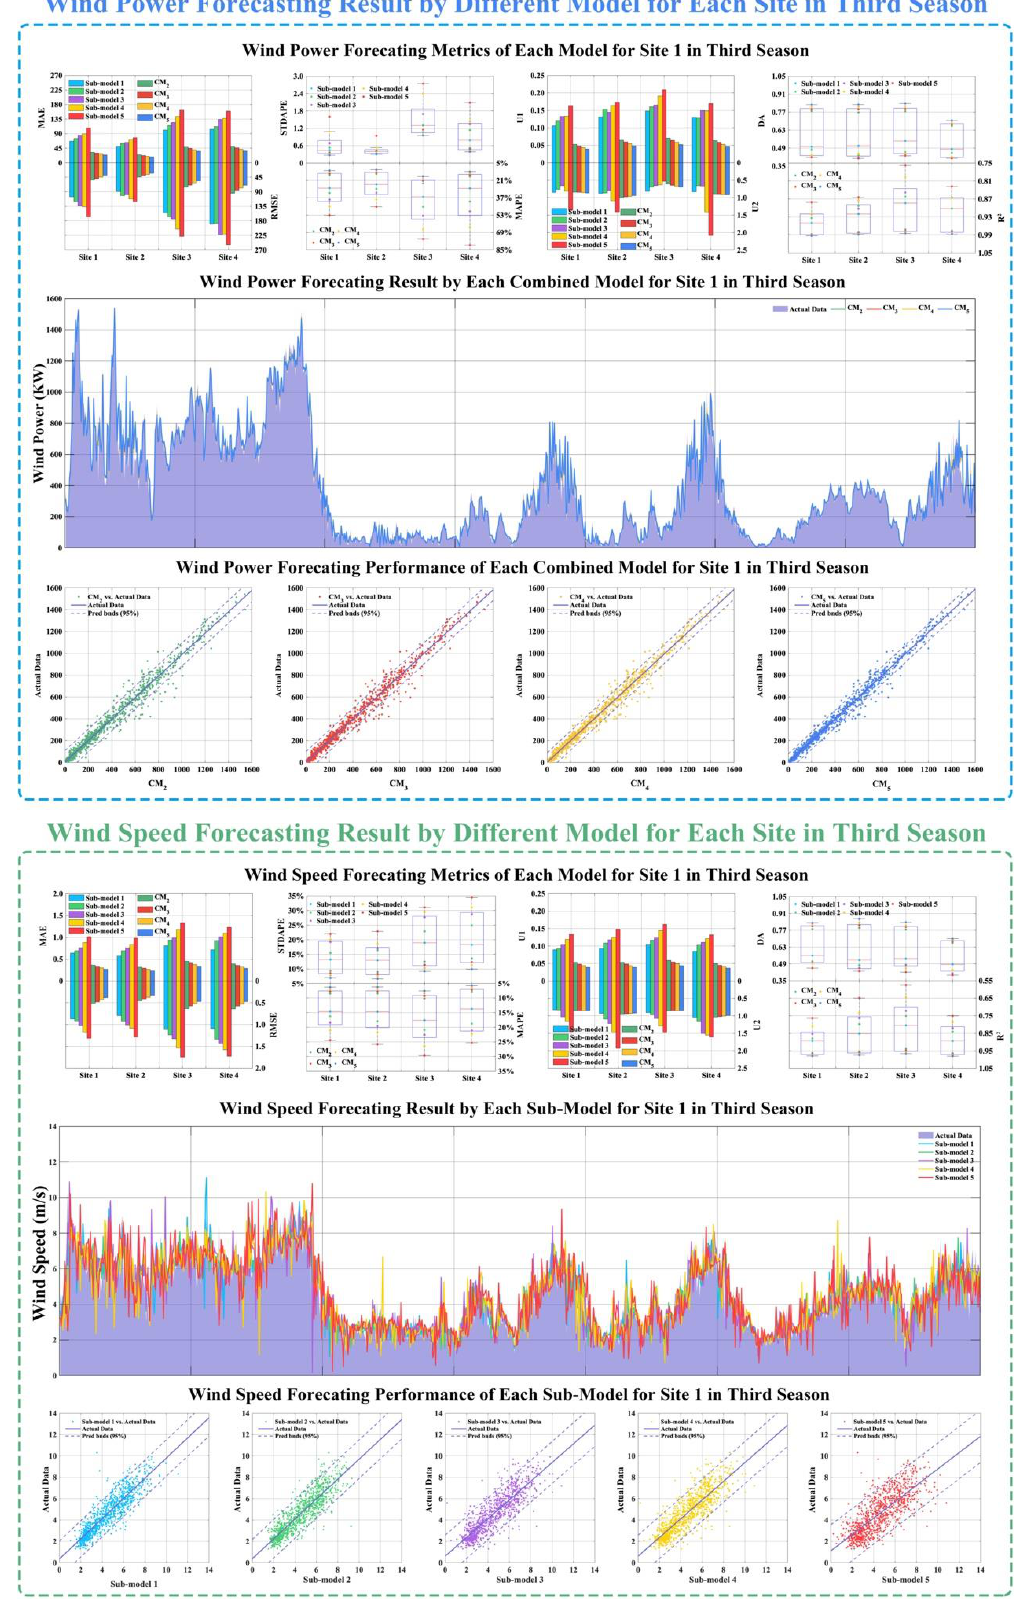
Figure 4. Wind speed and wind power forecasting result for each site in the third season.